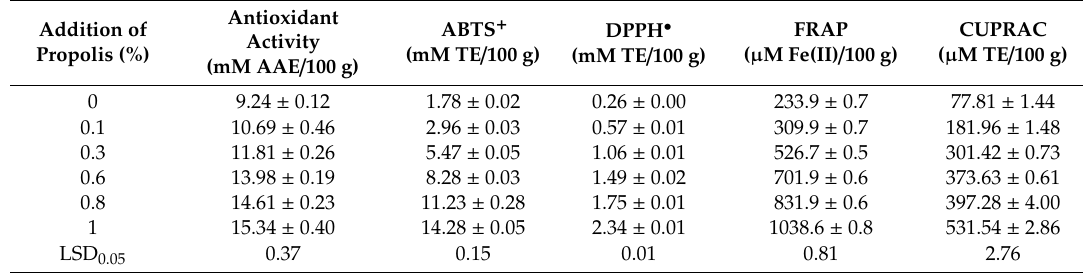
Table 4. The antioxidant, antiradical activity and reductive activity of multifloral honey and honeys enriched with